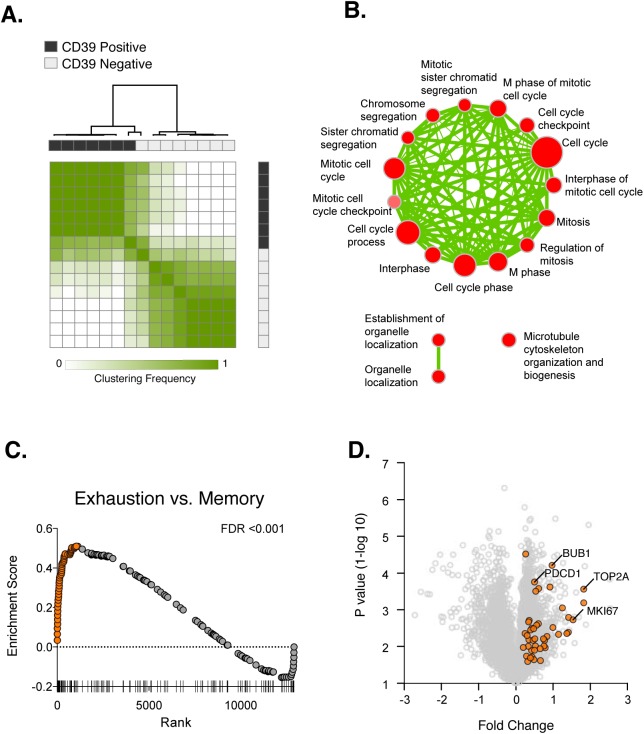
Transcriptional analysis of CD39+ and CD39– CD8+ T cells in HCV infection.
(A) Consensus hierarchical clustering of expression profiles from CD39+ (black) and CD39– (grey) CD8+ T cells from 8 HCV infected patients. Clustering is based on the top 10% of genes by variance across the dataset. Sample similarity (1-Pearson correlation coefficient) is annotated with color from low (white) to high (green). (B) Gene set enrichment map displaying Gene Ontology gene sets enriched (FDR < 0.1) in CD39+ CD8+ T cells from (A). Nodes (in red) are sized in proportion to gene set size; connecting line thickness represents extent of gene member overlap between gene sets. (C) Gene set enrichment analysis of a signature of 200 genes up-regulated in exhausted CD8+ T cells from the mouse model of chronic viral infection versus acute infection (day 30 post infection) in the ranked list of genes differentially expressed by CD39+ vs. CD39– CD8+ T cells. Leading edge genes are indicated by orange symbols. (D) Volcano plot of all genes (grey) or exhausted leading edge genes (orange) from (C).